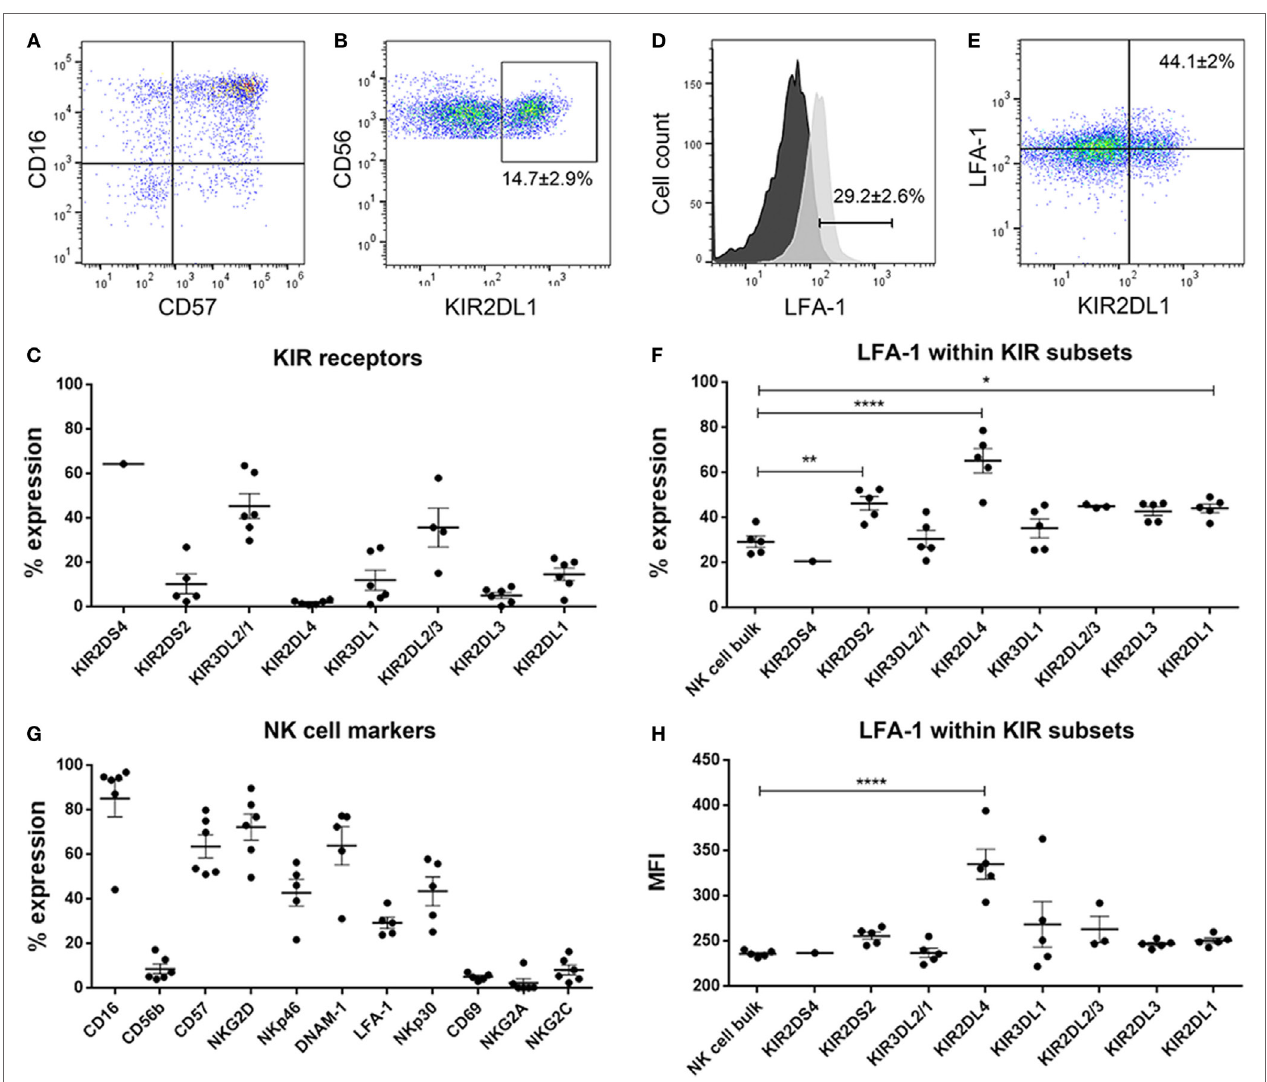
FigUre 5 | Dot plots showing (a) CD16 versus CD57 and (B) CD56 versus KIR2DL1 natural killer (NK) cells. % expression of (c) killer immunoglobulin-like receptors (KIR) receptors on donor-derived-NK cells. (D) Histograms showing surface expression % of LFA-1 in NK cell bulk. Black histogram—fluorescent minus one control and light gray histogram—expression of LFA-1 in sample. ( e) Dot plot showing LFA-1 versus KIR2DL1 in representative NK cells. % expression of (F) LFA-1 within the KIR subsets and (g) NK cell markers on donor-derived-NK cells. (h) MFI of LFA-1 within the KIR subsets. Data represent mean ± SEM of n = 6 donor-derived NK cells. One-way ANOVA, Bonferroni’s multiple comparison test, * P < 0.05; ** P < 0.01; **** P < 0.0001.